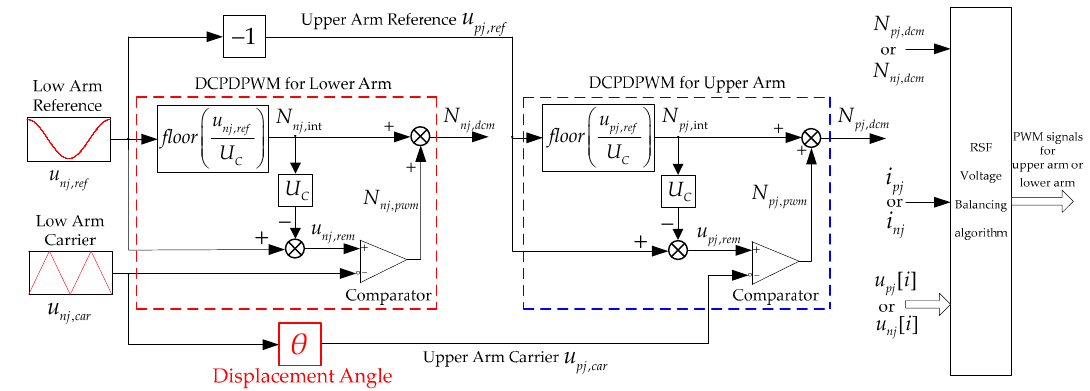
Figure 3. Block diagram of double-carrier phase-disposition pulse width modulation for MMCs.